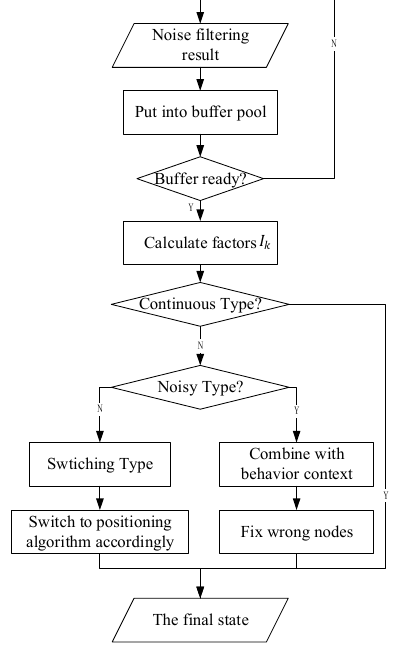
Figure 9. Flowchart of state chain method.